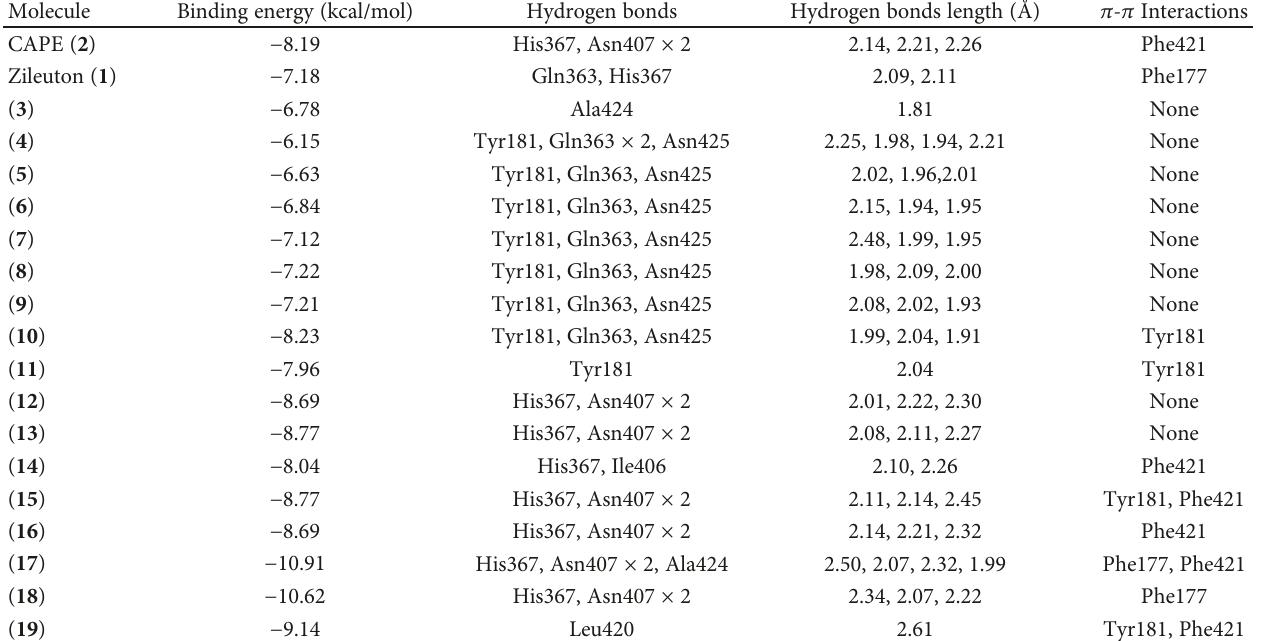
Table 2: Ligand binding energy, interactions, and hydrogen bond